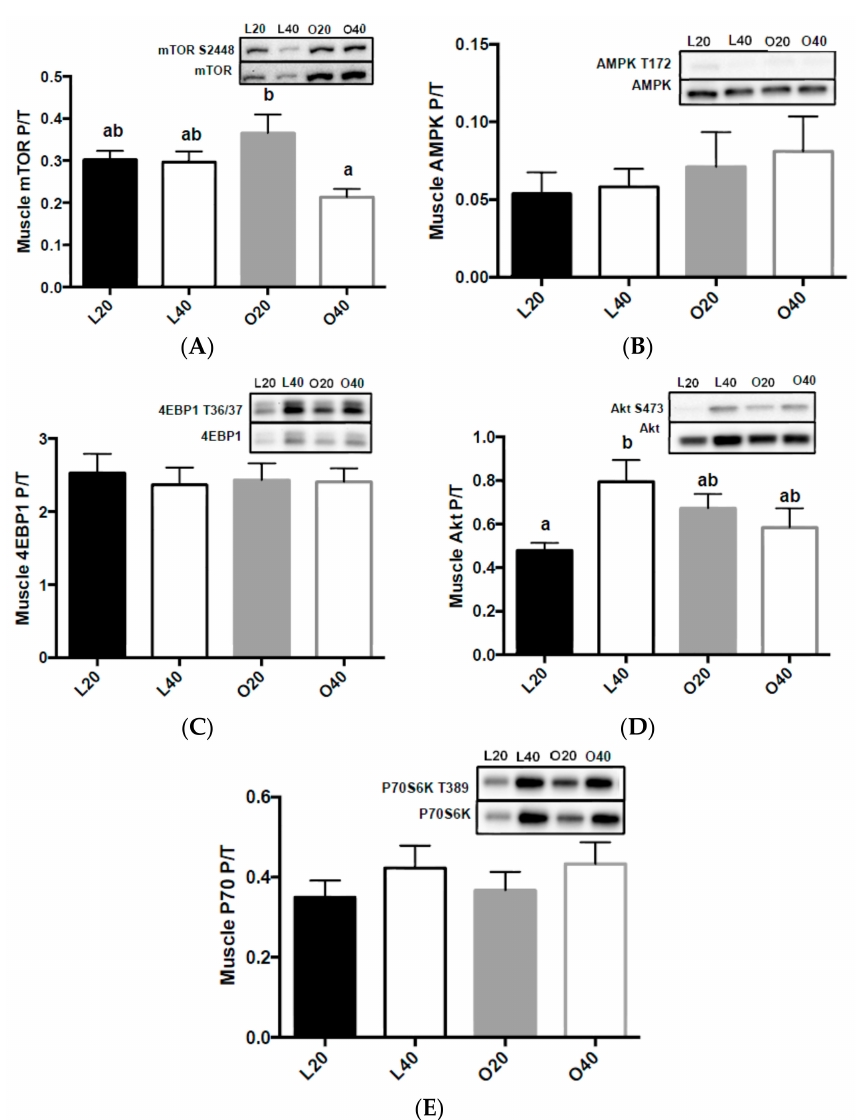
Figure 5. Changes in mTORC1 signaling in gastrocnemius muscle following 12-weeks of consuming either a 20% protein ( n = 8 per group) or 40% protein diet ( n = 10 per group) in lean control (L) or obese Zucker (O) rats. Representative blots are shown, all bands are from the same blot. ( A ) Mammalian target of rapamycin complex 1 (mTORC1) phosphorylation (S2448) over total protein; ( B ) 5 (cid:48) AMP-activated protein kinase (AMPK) phosphorylation (T172) over total protein; ( C ) Eukaryotic translation initiation factor 4E binding protein 1 (4EBP1) phosphorylation (S65) over total protein; ( D ) Protein kinase B (Akt) phosphorylation (S473) over total protein; ( E ) Ribosomal protein S6 kinase 1 (P70) phosphorylation (T389) over total protein. Values are means + SEM. Data was analyzed using one-way ANOVA. Values without a common letter differ, p < 0.05. L20, lean 20% protein; L40, lean 40% protein; O20, obese 20% protein; O40, obese 40% protein; P/T, phosphorylated/total